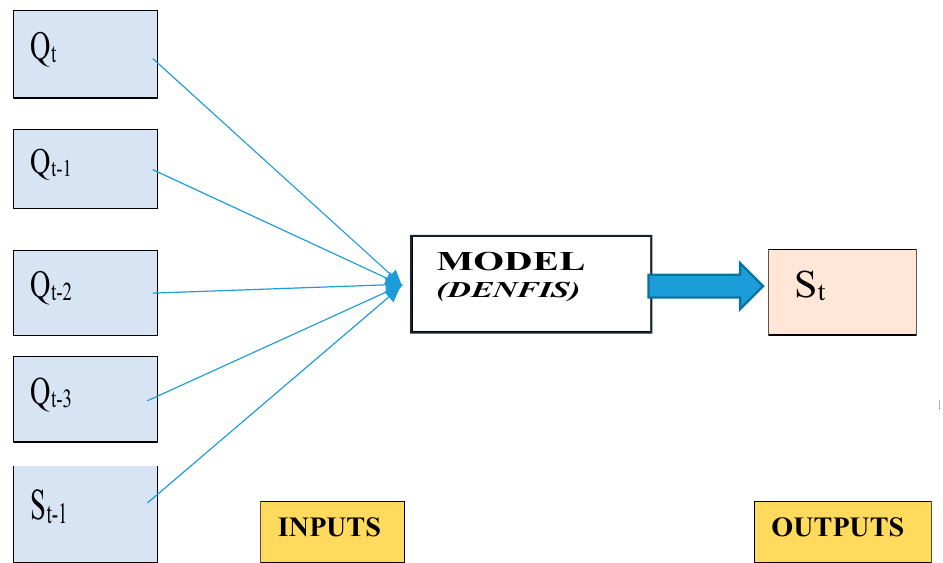
Figure 4. Schematic structure of the modelling system for the DENFIS-based model for scenario 5 (S5).